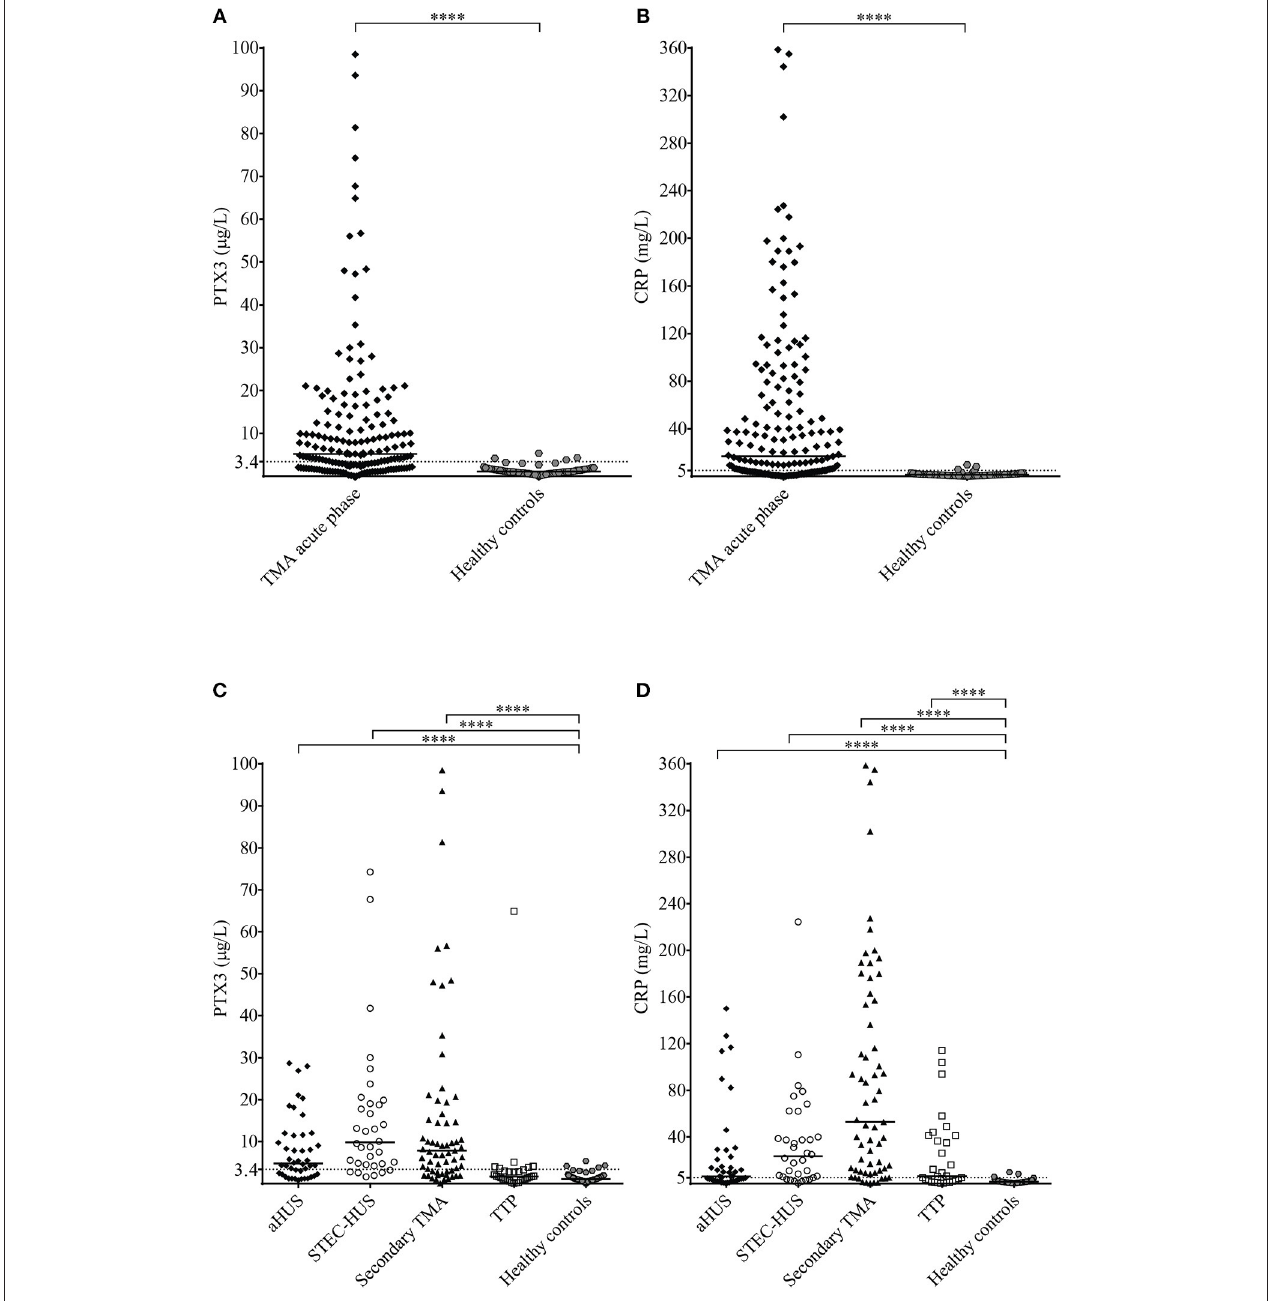
FIGURE 2 | PTX3 and CRP levels in acute TMA vs. healthy controls. (A,B) PTX3 and CRP levels of TMA patients at the acute disease onset compared to pentraxin levels of healthy individuals. (C,D) PTX3 and CRP levels of acute phase-TMA patients grouped by disease etiology. Data are expressed as mean of technical duplicates, the horizontal line indicates the median of each group, while an intermittent line shows the calculated cutoff of each pentraxin, respectively. Statistical analysis was performed with the Mann Whitney test (A,B) or the Kruskal-Wallis test corrected for multiple comparisons using the Dunn’s post hoc test (C,D) , respectively. Statistical significance is indicated by asterisks (**** p < 0.0001). aHUS, atypical hemolytic uremic syndrome; CRP, C-reactive protein; PTX3, pentraxin-3; STEC-HUS, Shiga-like toxin associated HUS; TMA, thrombotic microangiopathy; TTP, thrombotic thrombocytopenic purpura.